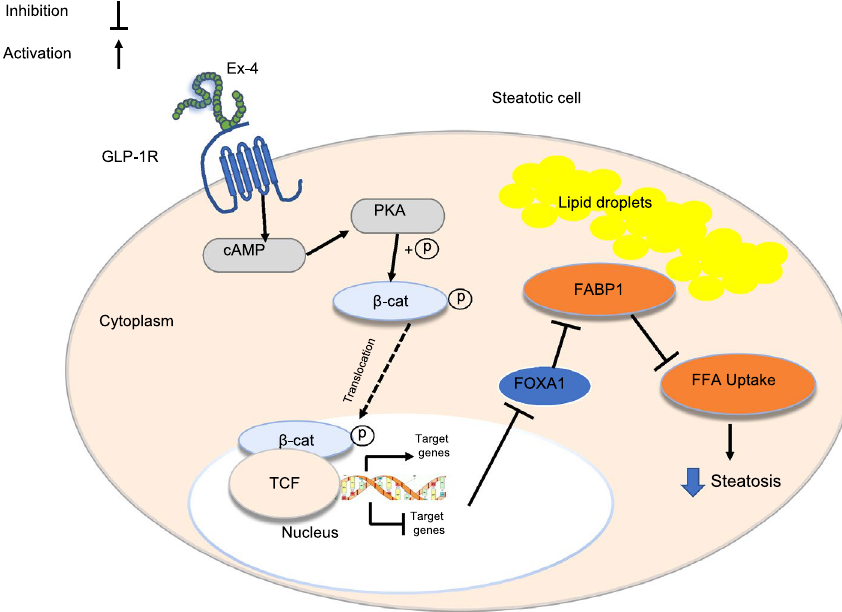
Figure 5. Proposed simplified signaling mechanism for Exendin-4-induced steatosis improvement. Exendin-4 action is mediated by directly binding to the Glucagon-Like Peptide-1 Receptor (GLP-1R) on the plasma membrane. The activation of the GLP-1R, which is coupled positively to the adenylyl cyclase (AC) system, stimulates AC and increases intracellular cAMP and activation of protein kinase A (PKA). The PKA phosphorylates and activates β-catenin, which is subsequently translocated to the nucleus. Nuclear β-catenin then binds to T-cell factor (Tcf) to form a bipartite transcription factor and facilitates the positive or negative modulation of the Tcf-dependent genes, leading, among other effects, to reduced expression of the transcription factor Forkhead Box A1 (FOXA1). The lower expression of FOXA1, one of the most effective activators of the human Fatty Acid Binding Protein 1 (FABP1), results in downregulation of FABP1, which leads to reduced uptake and transport of fatty acids and ultimately decreased